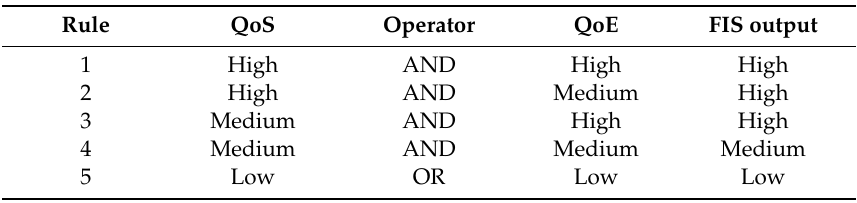
Table 3. The rules for the FIS3